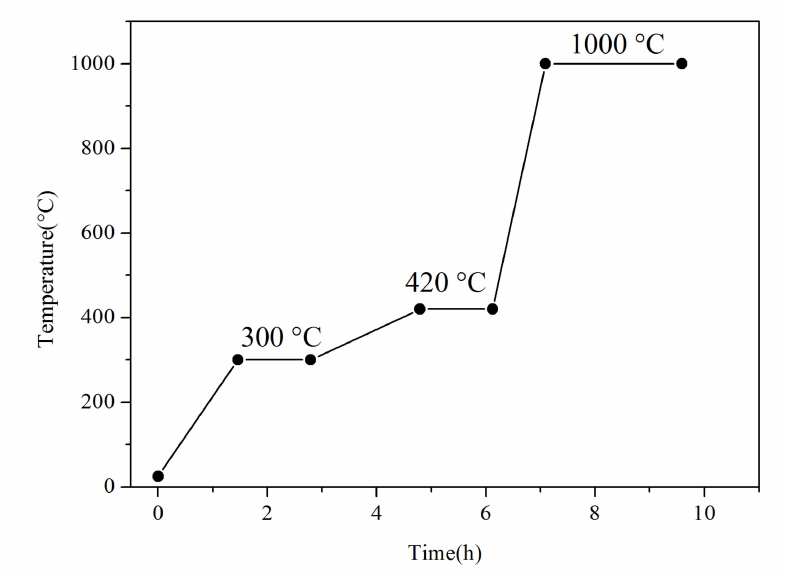
Figure 1. Vacuum sintering process of Al 0.25 FeNiCoCr powders and FeB-30 wt.% Al 0.25 FeNiCoCr powders.